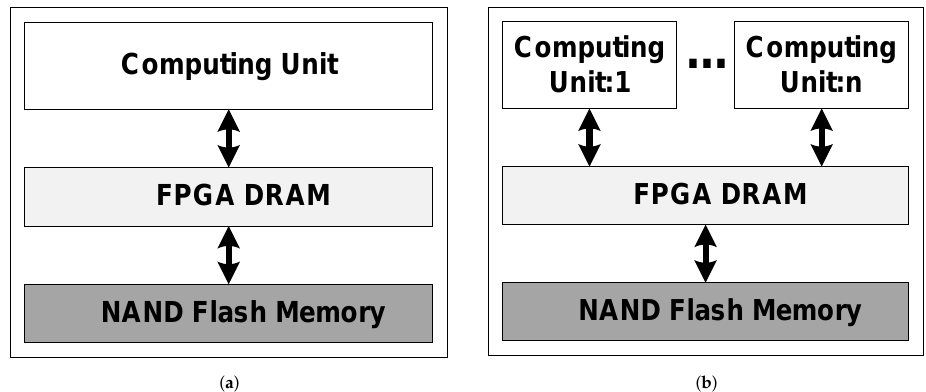
Figure 5. Architecture comparison between sigle and multiple computing units within CSD. ( a ) Sin- gle computing unit with option (–nk CUName:1) . ( b ) Multiple computing unit with option (–nk CUName:n)